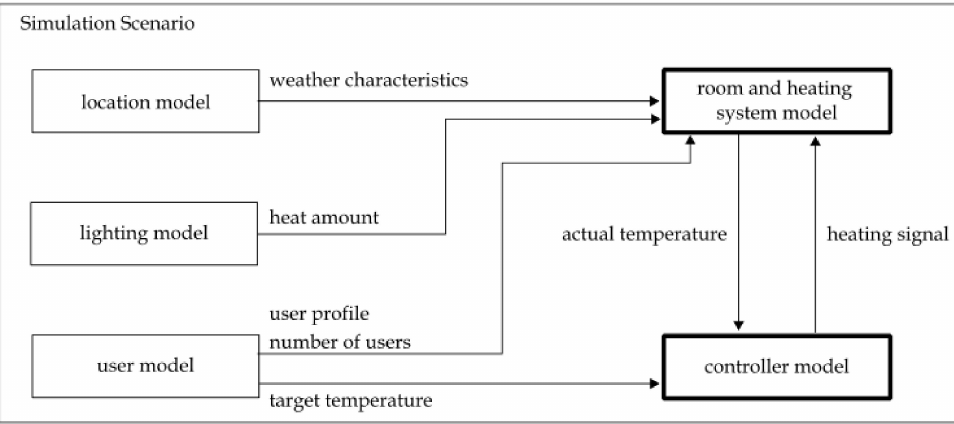
Figure 1. Submodels of a simulation scenario (Supplementary